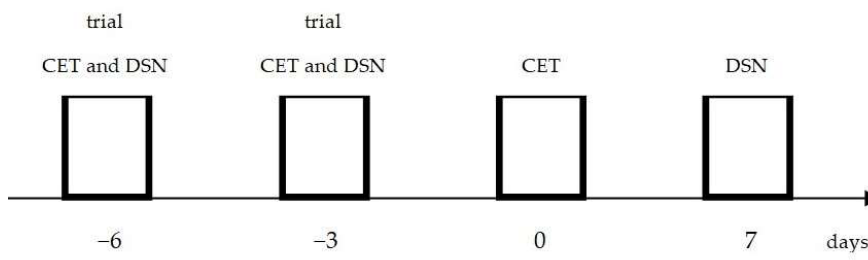
Figure 1. Scheme of the trial and basic exercise tests.